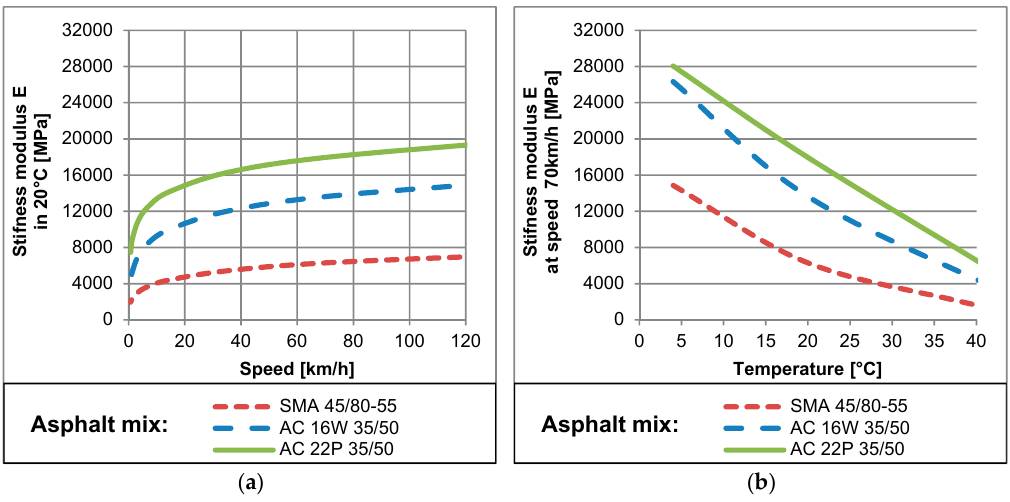
Figure 7. ( a ) Relationship between the stiffness modulus and vehicle speed at a constant temperature of 20 °C; ( b ) Relationship between the stiffness modulus and the temperature at a constant vehicle speed of 70 km/h, for three types of asphalt mixtures usually used in pavement structures. Table 1. Thicknesses and mechanical parameters of particular pavement layers assumed for analyses. Poisson Ratio v i (-) Stiffness Modulus E i (MPa) Layers of the Pavement Structure at Temperatures at Temperature Vehicle Speed Layers of the Pavement (Km/h)